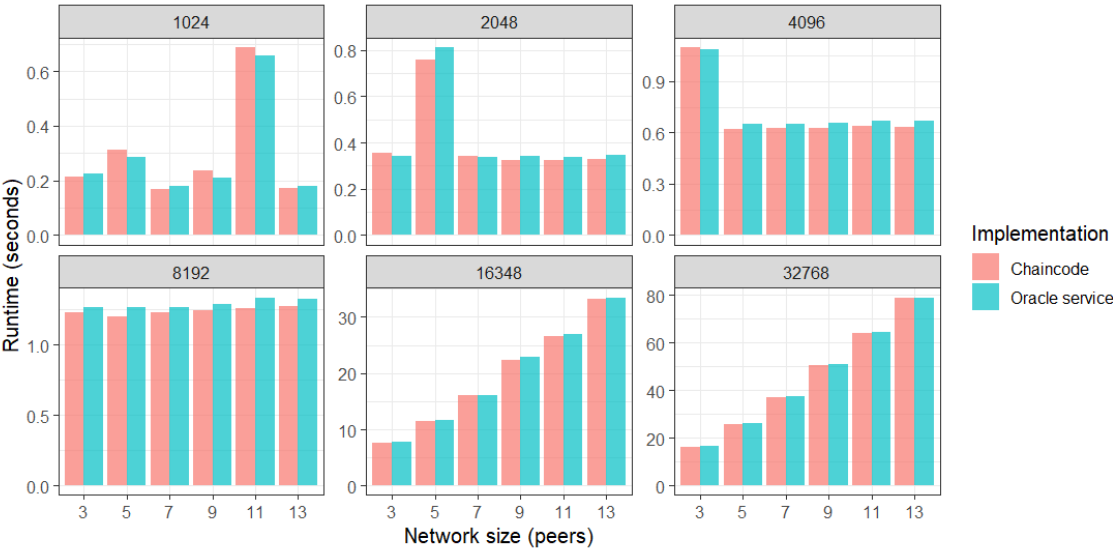
Figure 8. Model inference runtime (in seconds) depending on the network size for different amounts of the synthetic dataset.